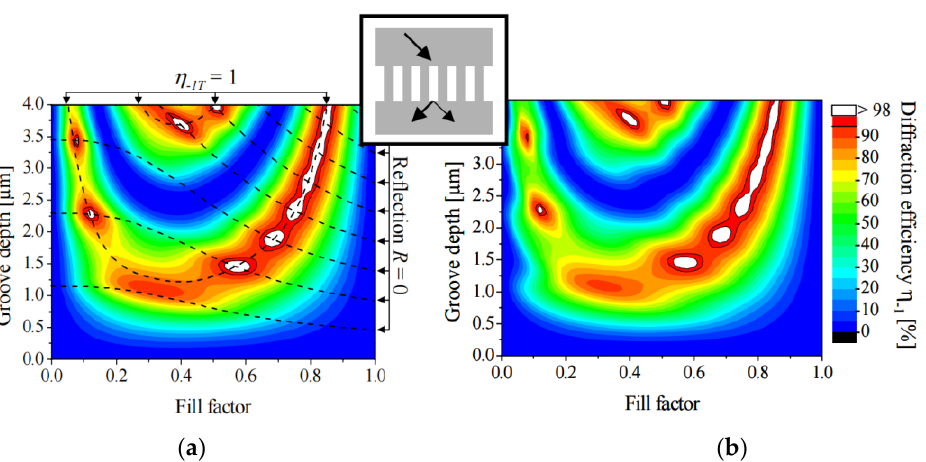
Figure 25. ( a ) Simulation of the diffraction efficiency of a buried grating with a 600 nm period as a function of the profile parameters (wavelength 1064 nm and Littrow configuration). ( b ) Correspond- ing numerical calculation by rigorous Fourier modal method.